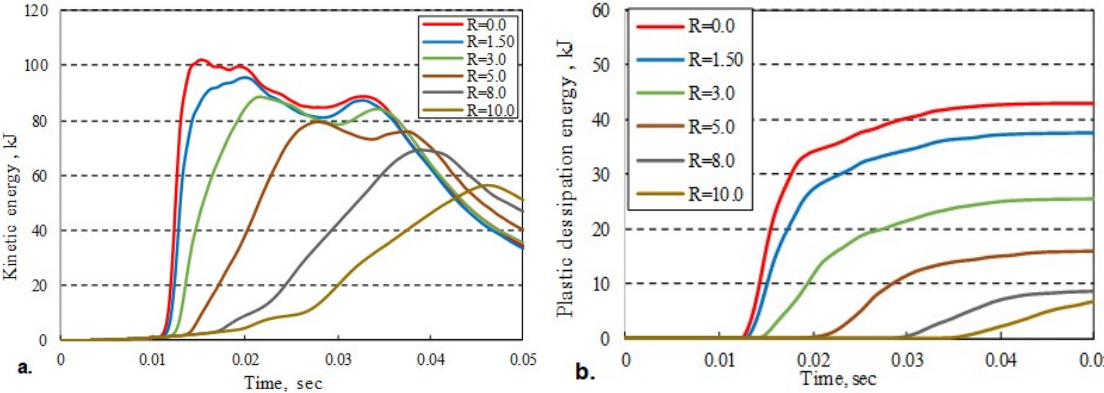
Figure 18: a. Kinetic energy with time. b. plastic dissipation energy with